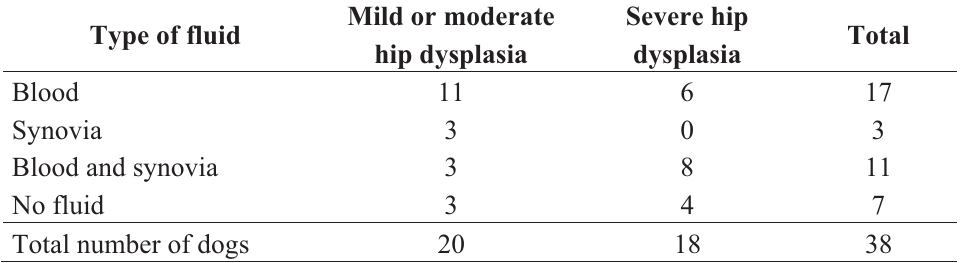
Table 1. Number of dogs with blood and/or synovia leakage from the implantation needles during insertion of gold beads around the hips among 38 dogs with hip dysplasia.